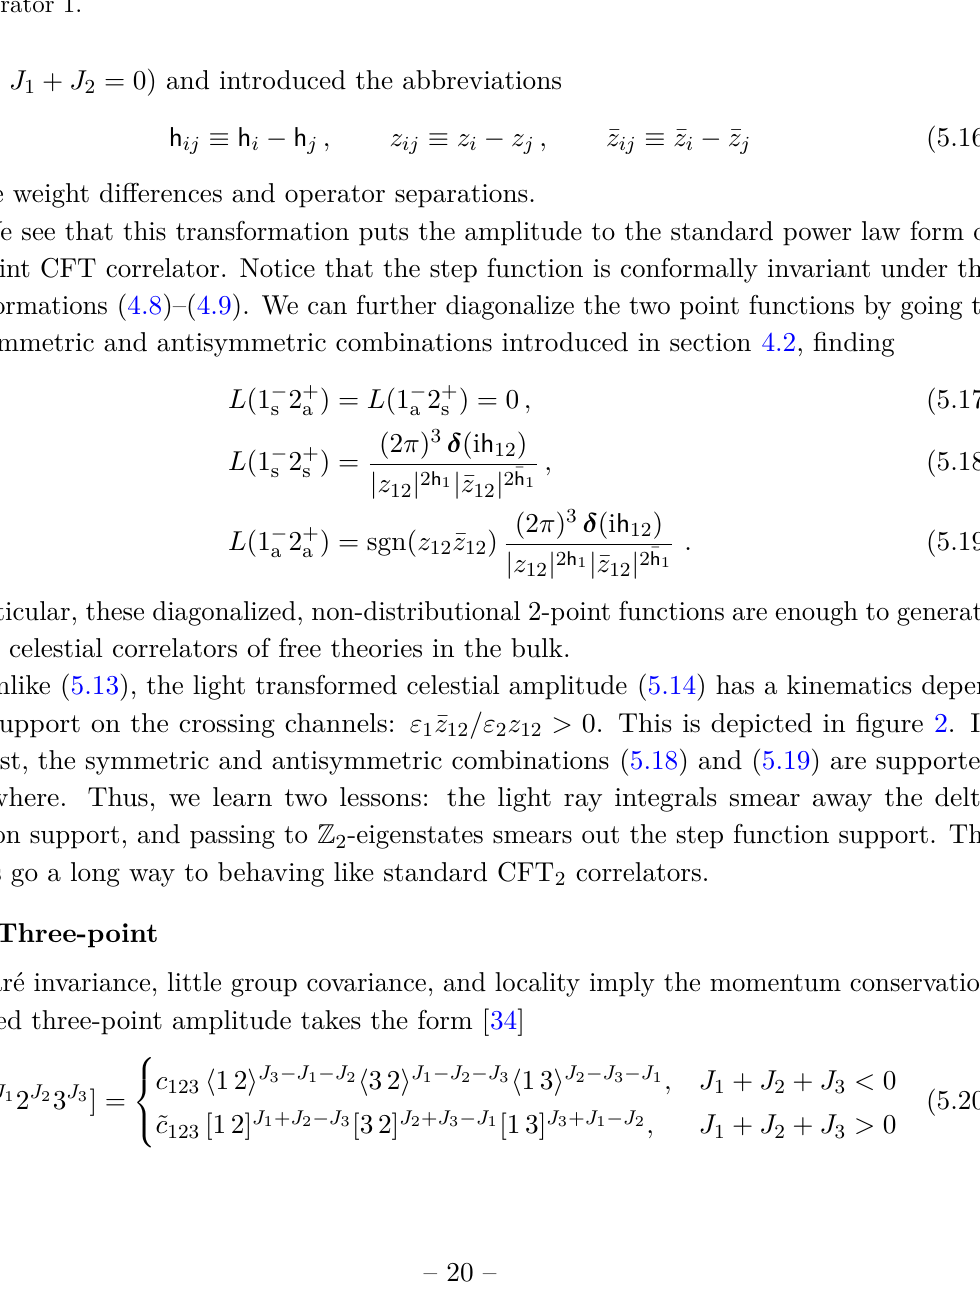
Figure 2 . Let’s keep track of the support for different channels. Here is the two point case indicating which regions defined by the (1 , 1) lightcones emanating from operator 2 support various channels for operator